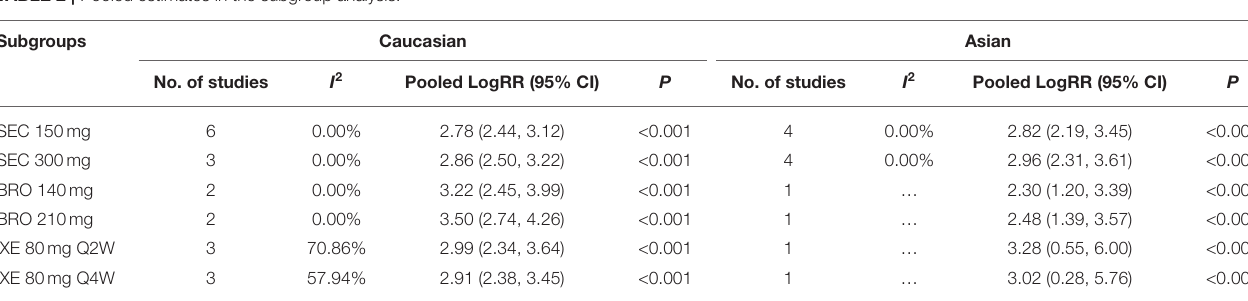
TABLE 2 | Pooled estimates in the subgroup